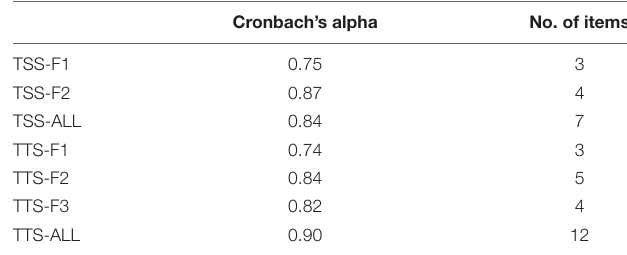
TABLE 11 | Cronbach’s alpha for the TSS and the TTS internal consistency